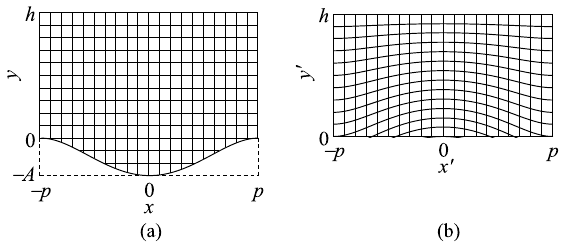
Fig. 4. Coordinate transformation for the groove illusion medium. (a)OriginalCartesiancoordinatesystem( x , y ).(b)Transformednon- conformal coordinate system ( x 0 , y 0 ).